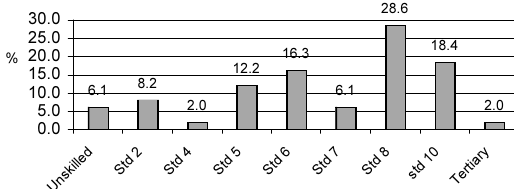
Figure 2: Education of unskilled labourers